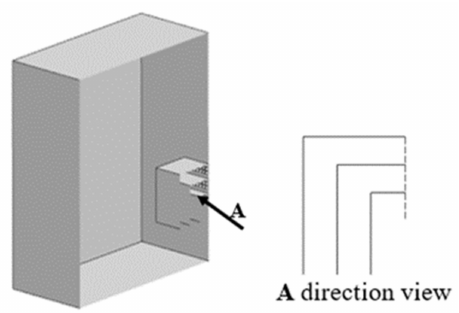
Figure 14. The 90 ◦ diaphragm structure diagram.